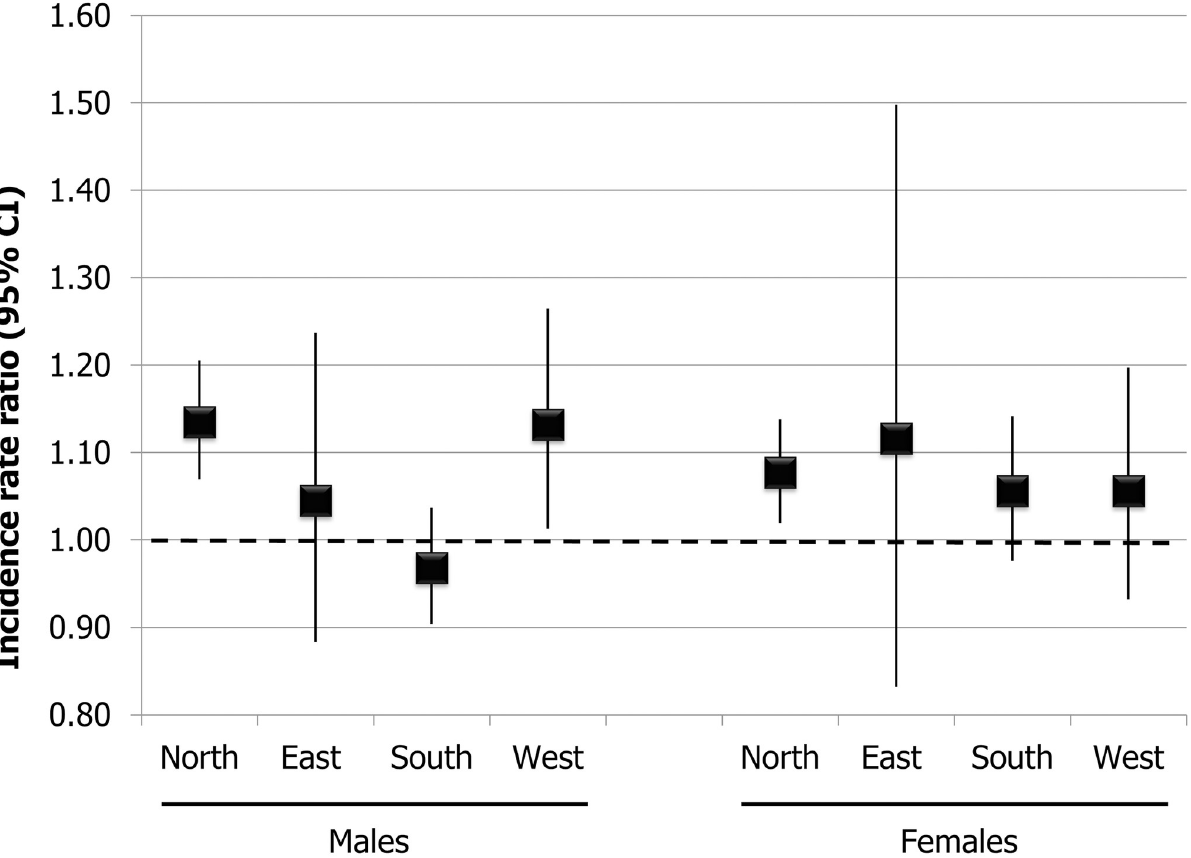
Fig 2. Age and period-adjusted incidence rate ratios of smoking cessation, with 95% confidence intervals, for subjects who started smoking at 16 years or later compared to those who started earlier, by sex and European region.